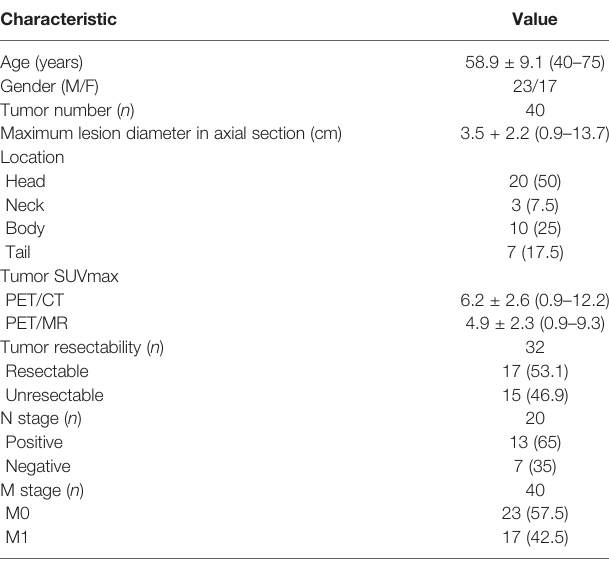
TABLE 1 | Basic information of the 40 patients with pancreatic cancer. Characteristic